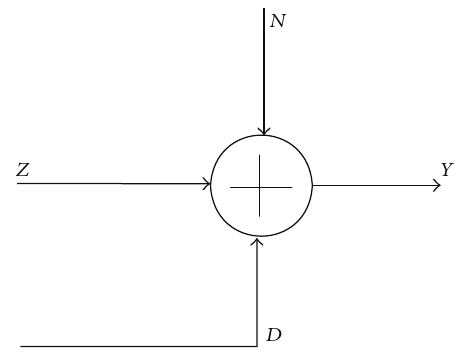
Figure 2: Channel model in the presence of clutter and additive Gaussian